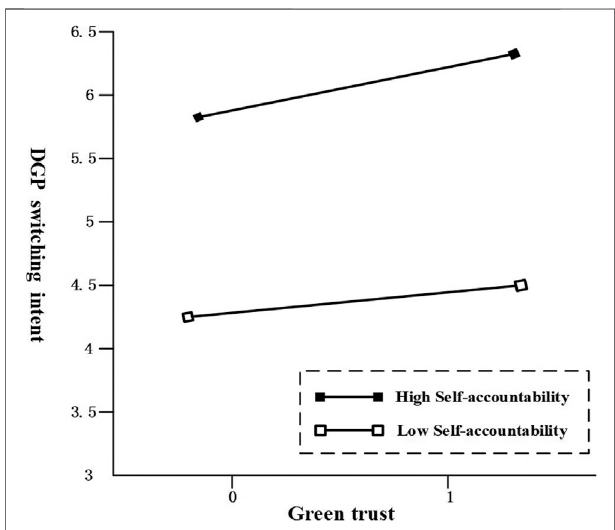
FIGURE 2 | Moderating role of